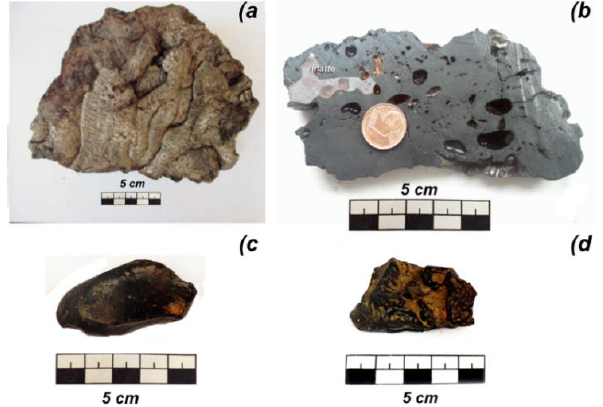
Figure 3. Macroscopic images of sampled slags: ( a ) sample from Cugnano with evident flowing texture and ( b ) abundant, large porosity and inclusion of matte (white) visible in the cross-section; ( c , d ) small glassy samples from Montieri with scarce flowing texture.